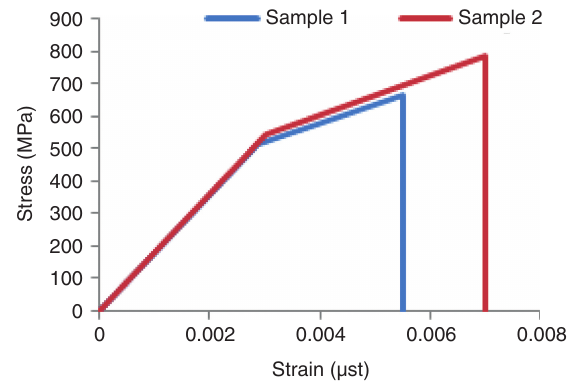
Fig. 5. Stress-strain curve for the steel reinforced bar (Sample 1 for beams G1D & G2R1, sample 2 for beams G3R2 & G4R3)